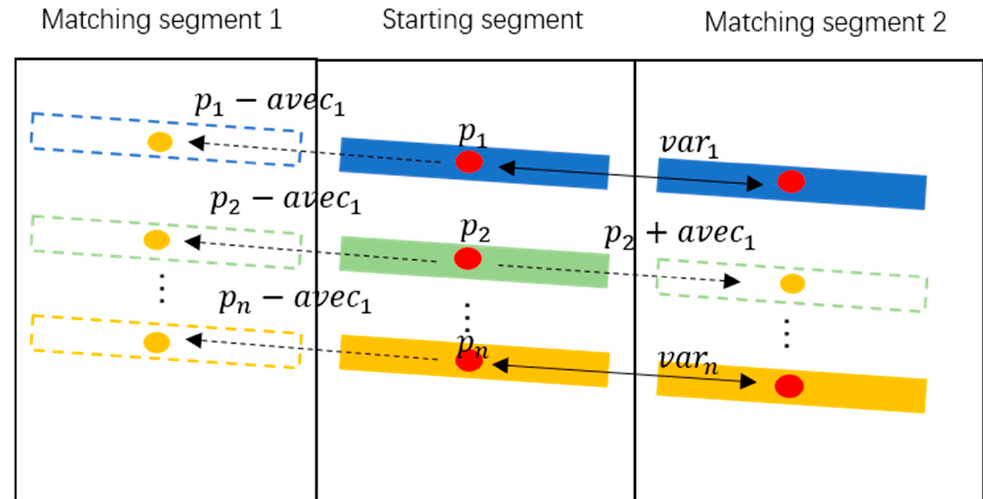
Figure 9. Gap repair method. Red circles are centroids of matched powerline candidates, orange circles are estimated centroids. Colored rectangles represent powerline candidates, and dotted rectangles represent gaps. p 1 – p n denote centroids of candidates in the starting segment. var 1 – var n are the changes in centroids of the matched powerline candidates between the starting segment and matching segment1, avec 1 is the average value of them.